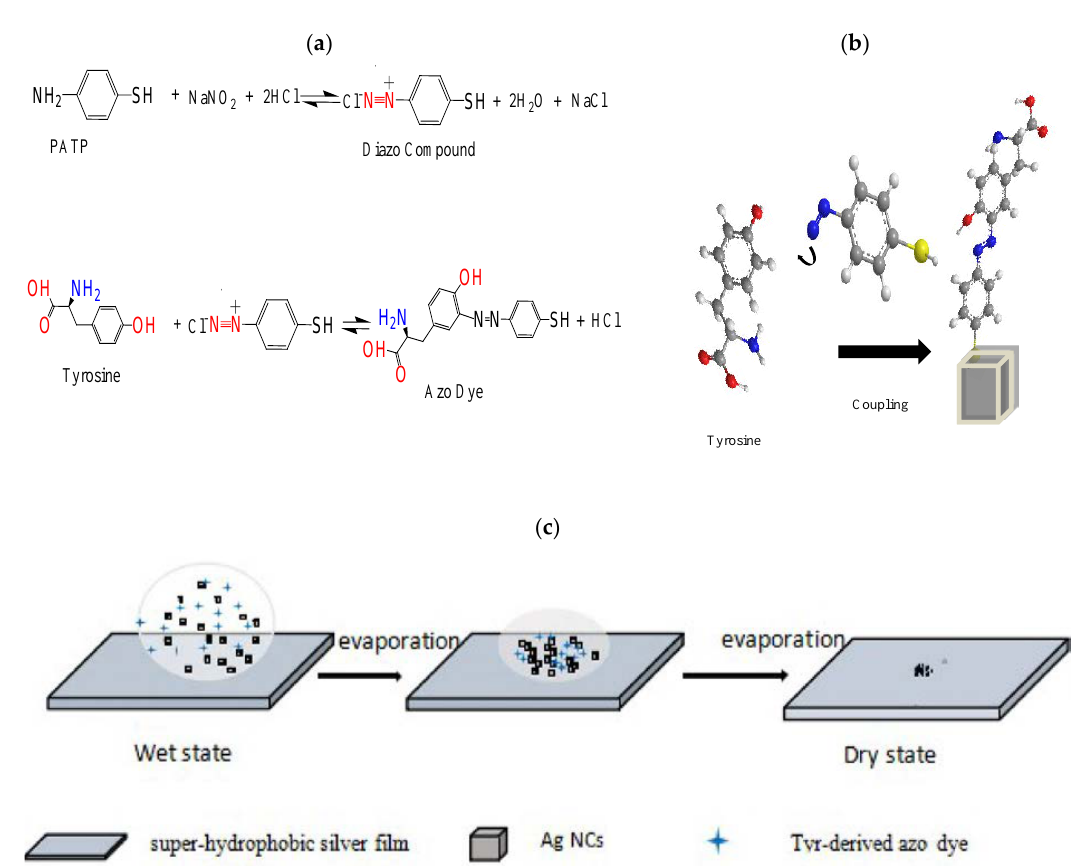
Figure 1. Schematic illustration of detection of Tyrosine (Tyr)-derived azo dye on a super-hydrophobic silver film coated with silver nanocubes (AgNCs) as a substrate. ( a ) Azo coupling reaction; ( b ) Azo coupling and Surface-enhanced Raman scattering (SERS)-based Tyr detection; ( c ) Dynamic contraction process of the analyte on the super-hydrophobic silver